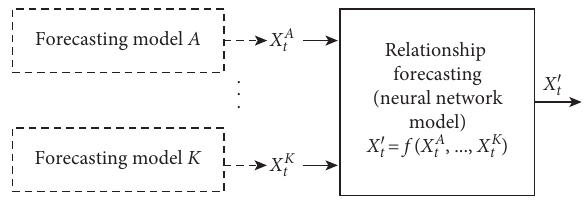
Figure 5: The relationship forecasting in the second